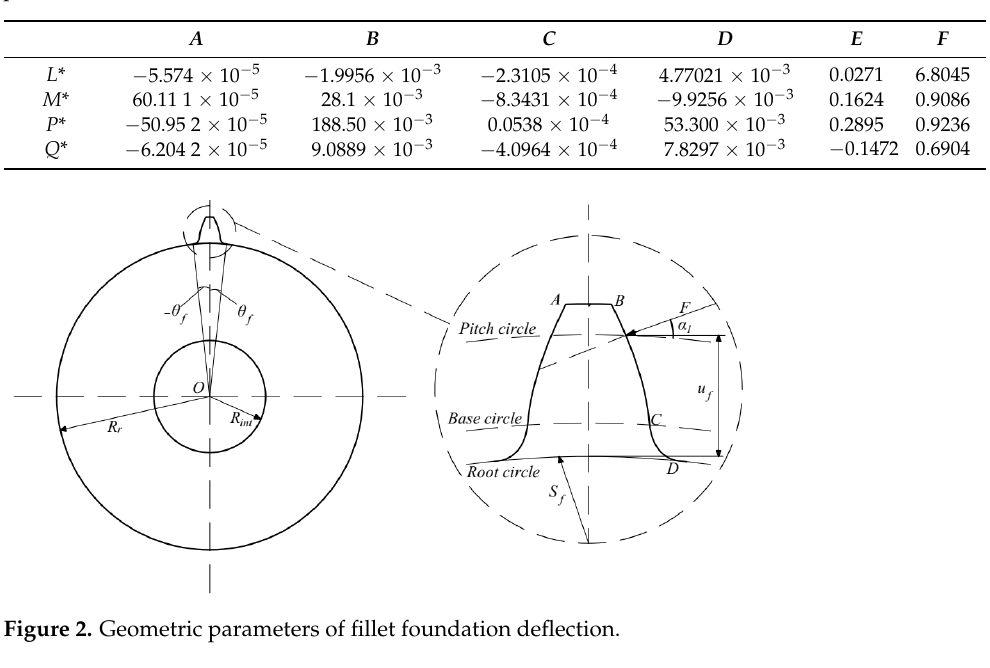
Table 1. Coefficient values of the analytical formula for gear deflection (Reprinted/adapted with permission from Ref. [5], 2009, Chaari, F.)